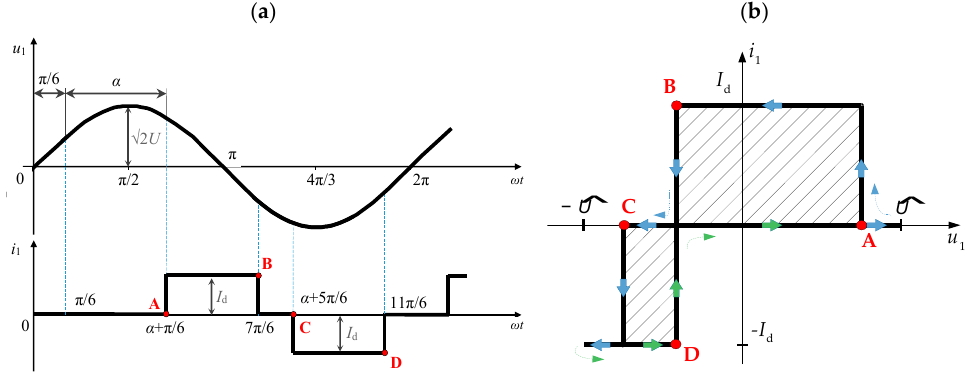
Figure 8. Typical waveforms of current and voltage ( a ) and u – i characteristic ( b ) of a semiconverter for 𝛼 > 60° .